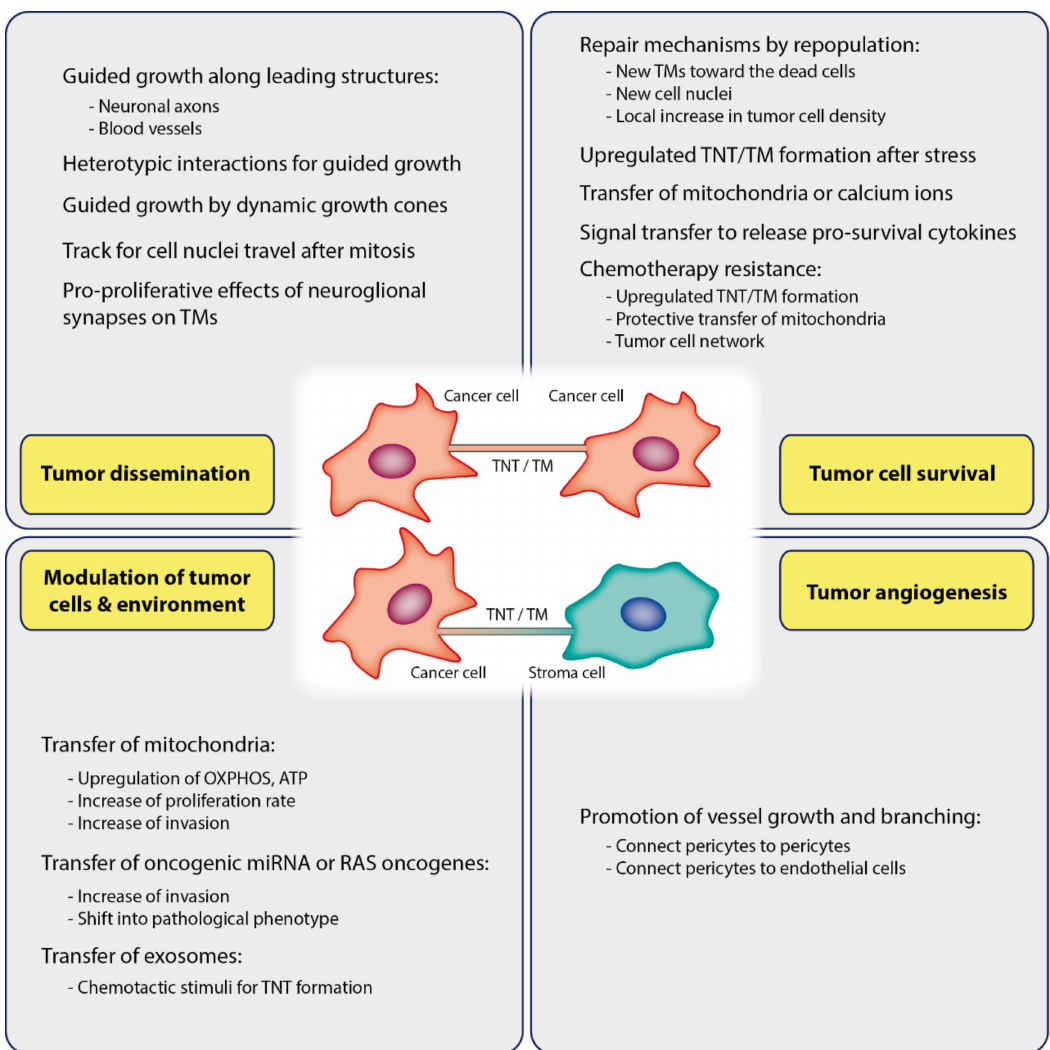
Figure 2. Functions of TNTs / TMs in cancer. TNTs / TMs are critically involved in tumor initiation, growth, progression, metastasis, and chemotherapy